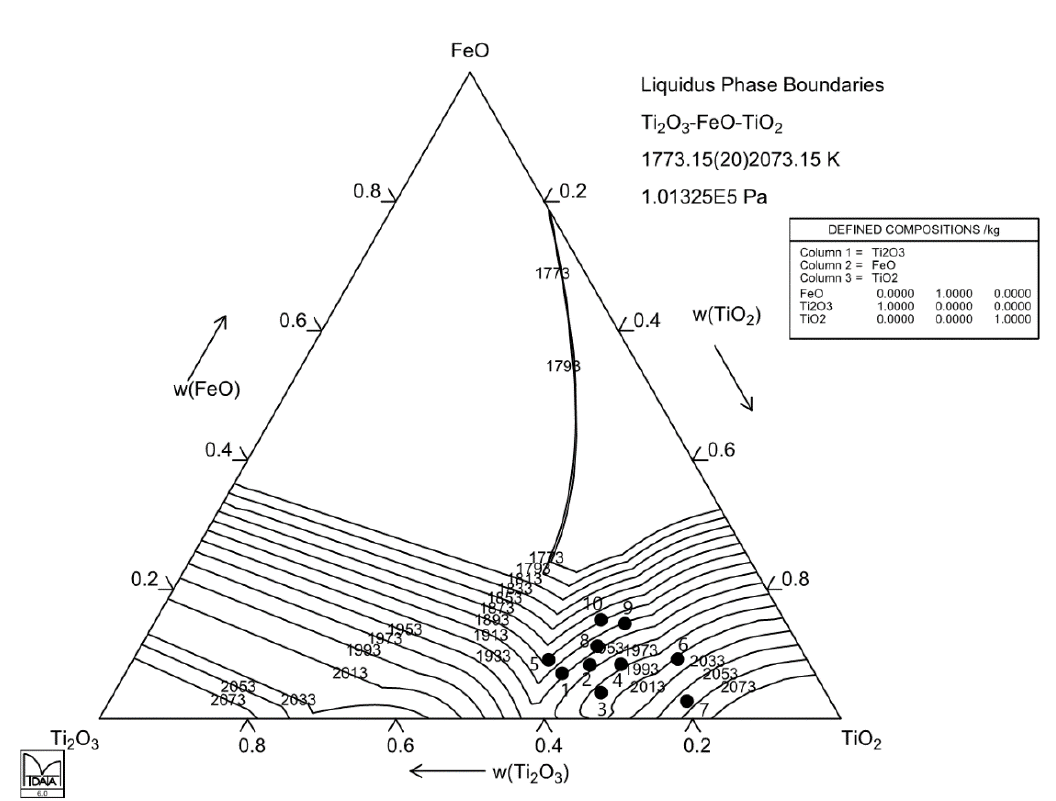
Figure 4. Liquidus contour diagram that was used for the calculation of liquidus temperature. The composition of all samples is shown in the figure, which was used to determine the temperature.